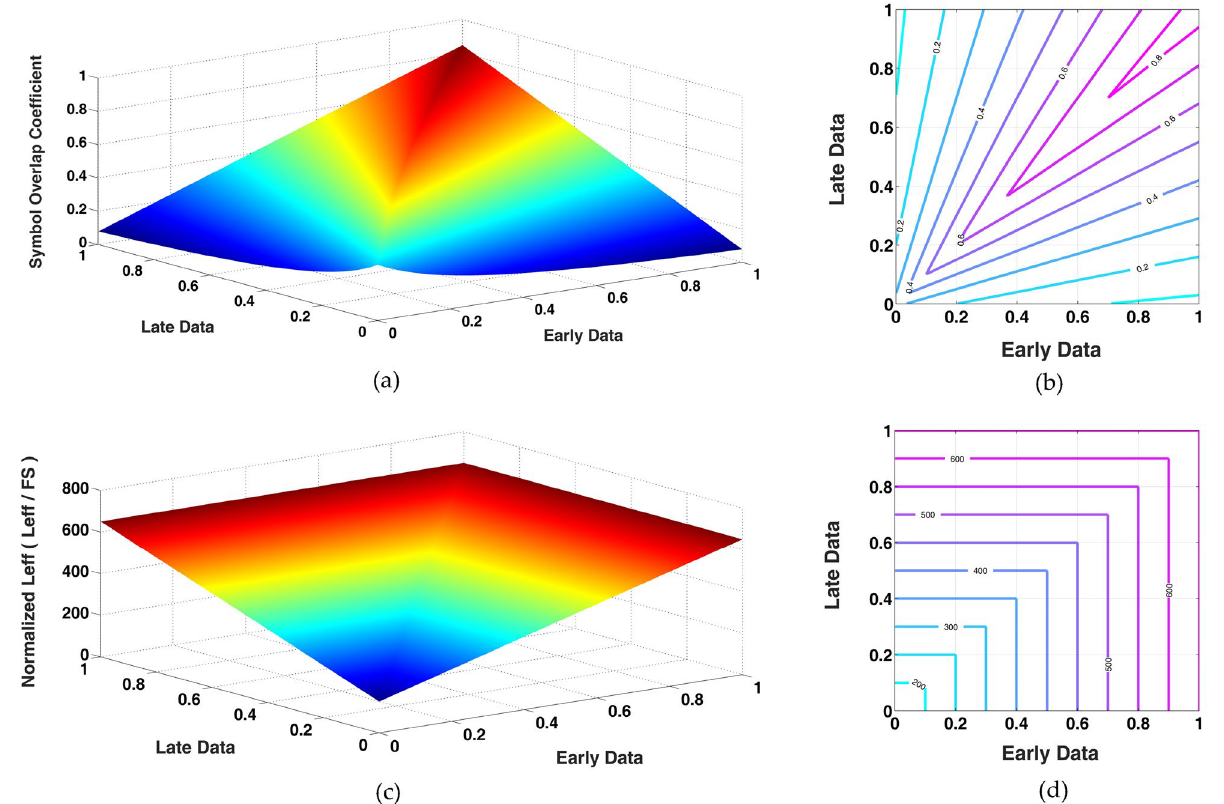
Figure 3. Contribution of the length of early and late symbols to symbol overlap and symbol length in IPM coding. ( a ) Symbol overlap coefficient for all possible combinations of two data samples, ( b ) the contour graph (values on the graph represents the corresponding OC Smb on each line) for the 3D plot in part a, ( c ) normalized effective symbol length of IPM-coded signal for all possible combinations of two data samples, and ( d ) the contour graph (values on the graph represents the corresponding L eff on each line) for the 3D plot in